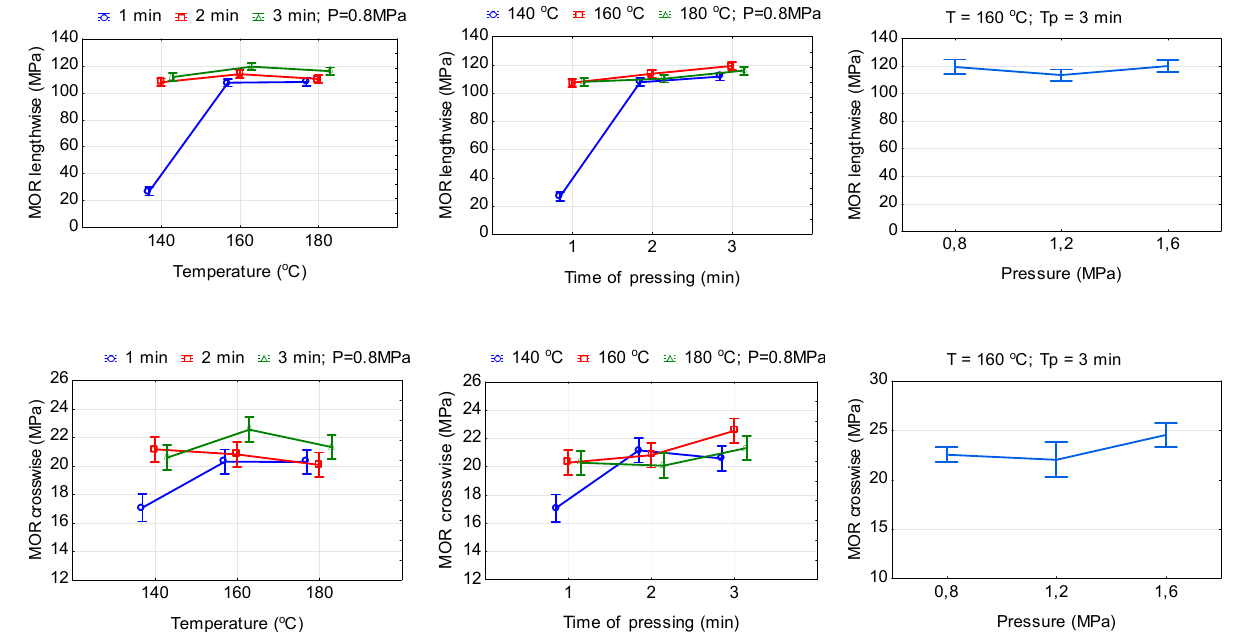
Figure 6. The relationship between bending strength and hot-pressing parameters (lengthwise = in parallel and crosswise = in perpendicular directions).